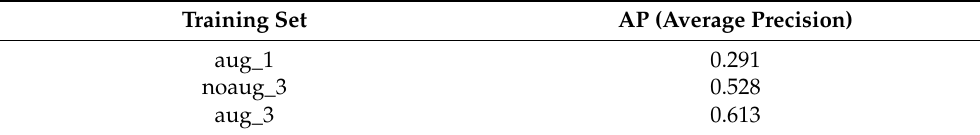
Table 1. Comparison of different data augmentation strategies (AUG_3, NOAUG_3, AUG_1).